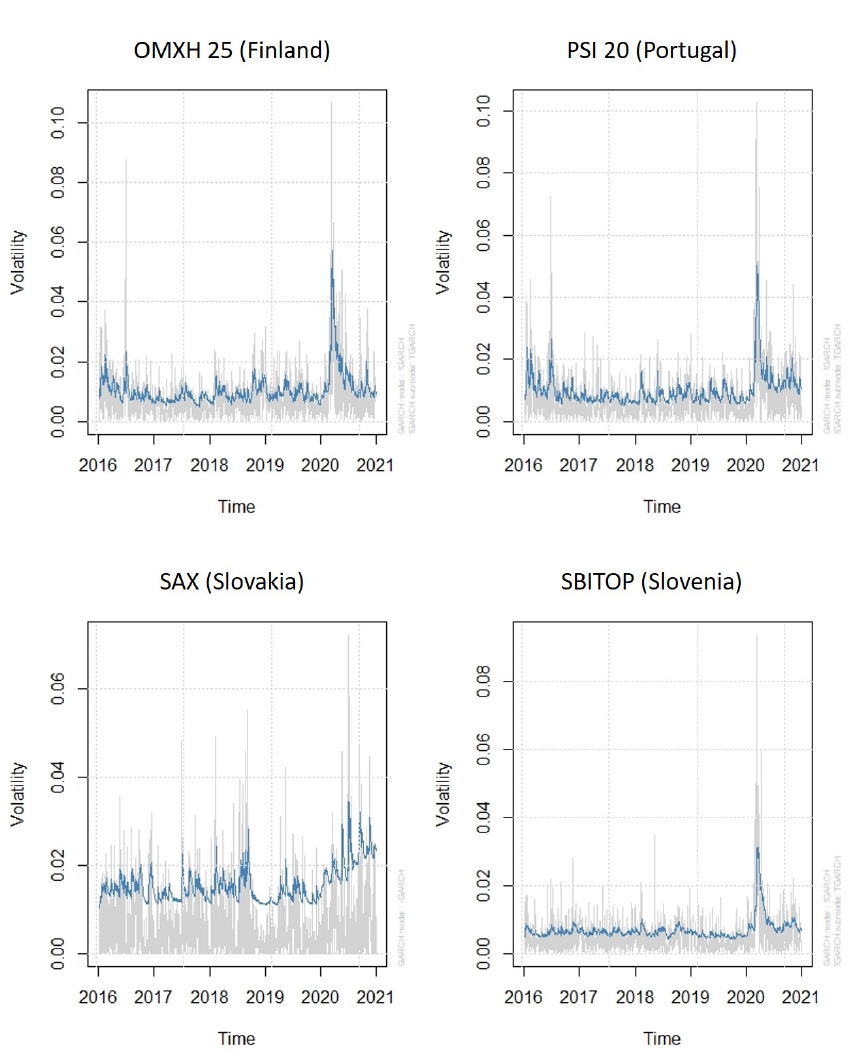
Figure A3. Estimated conditional standard deviation (volatility) versus absolute daily returns of euro area stock indices. Period from 4 January 2016 to 31 December